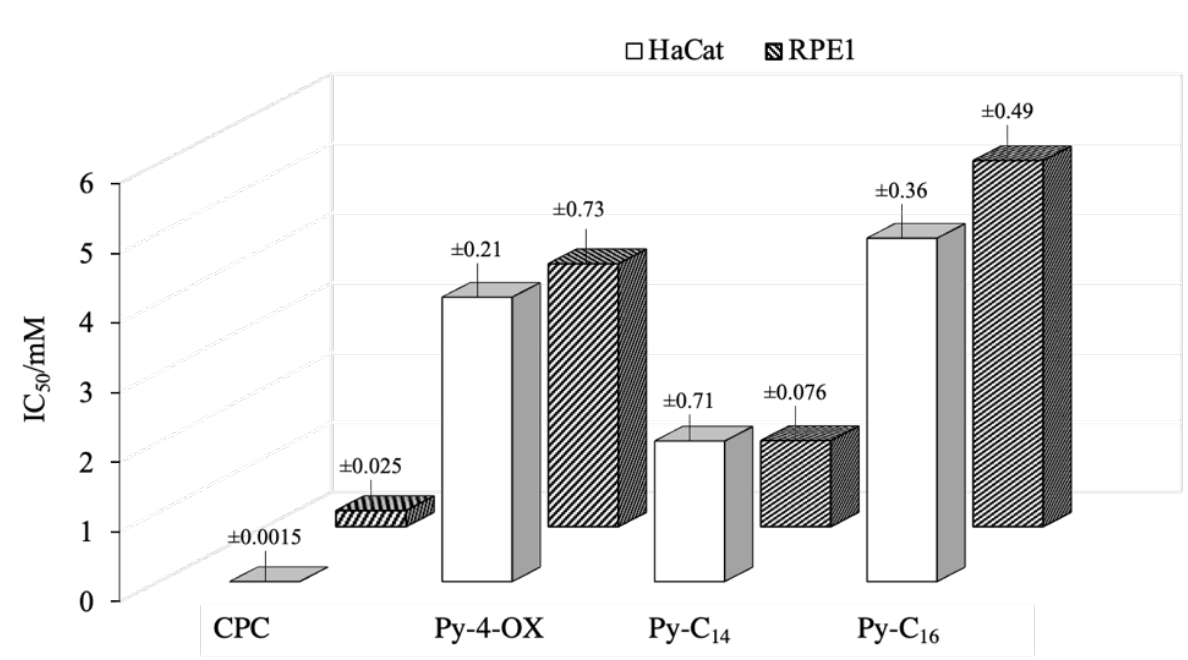
Figure 2. Cytotoxicity of CPC , Py-4-ox , Py-C 14 , and Py-C 16 expressed as a concentration (IC 50 /mM) of the compounds at which 50% inhibition of cell growth is observed. Experiments were performed in triplicate and results are given as means of three independent experiments, with standard deviations presented as error bars. The experiments were performed with HaCaT and RPE1 cells.